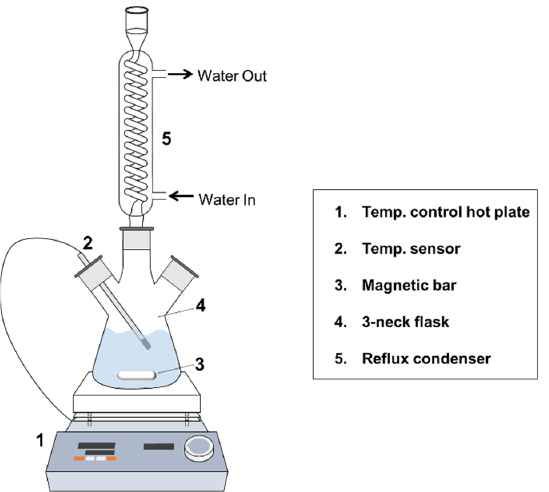
Figure 2. Experimental setup for leaching of REMs from discarded NiMH batteries.